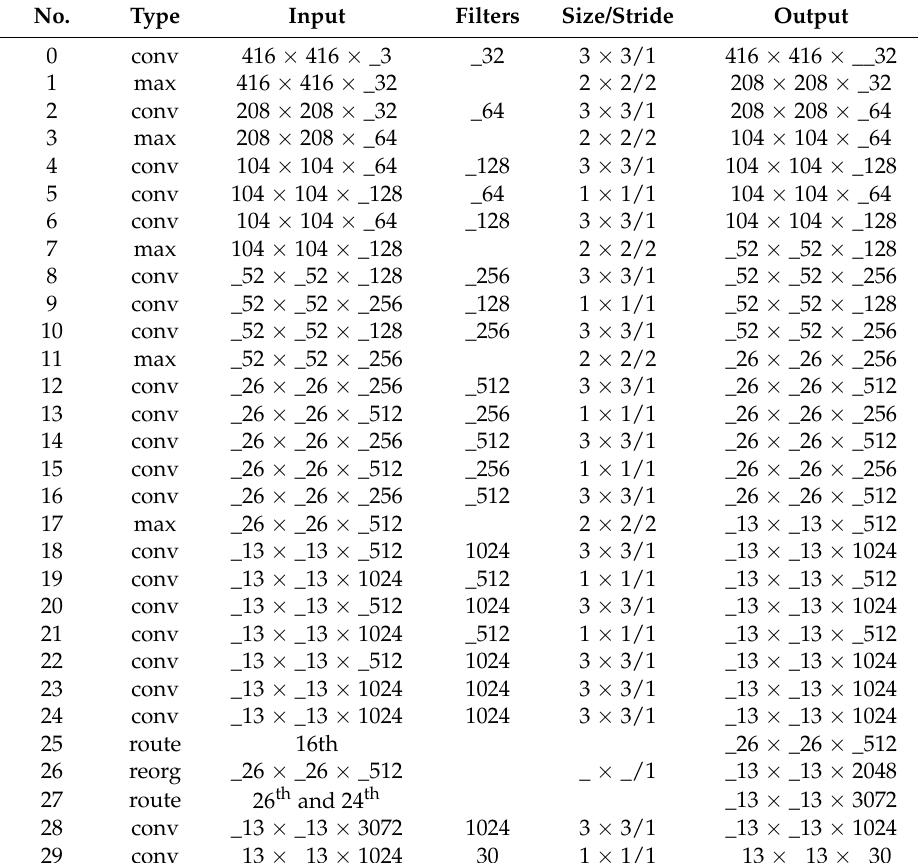
Table 1. You Only Look Once version 2 (YOLOv2) Network